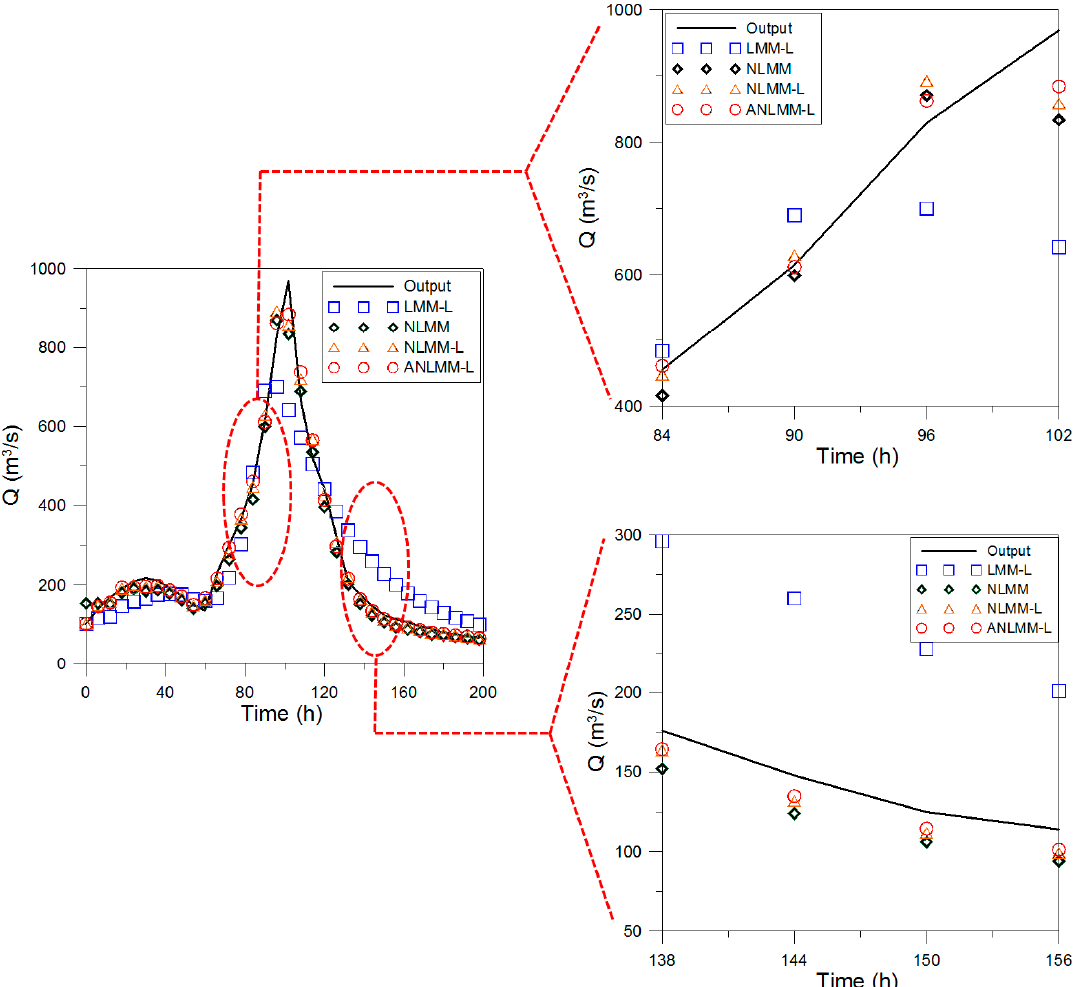
Figure 4. Comparison of results for the flood data of River Wye December in 1960.